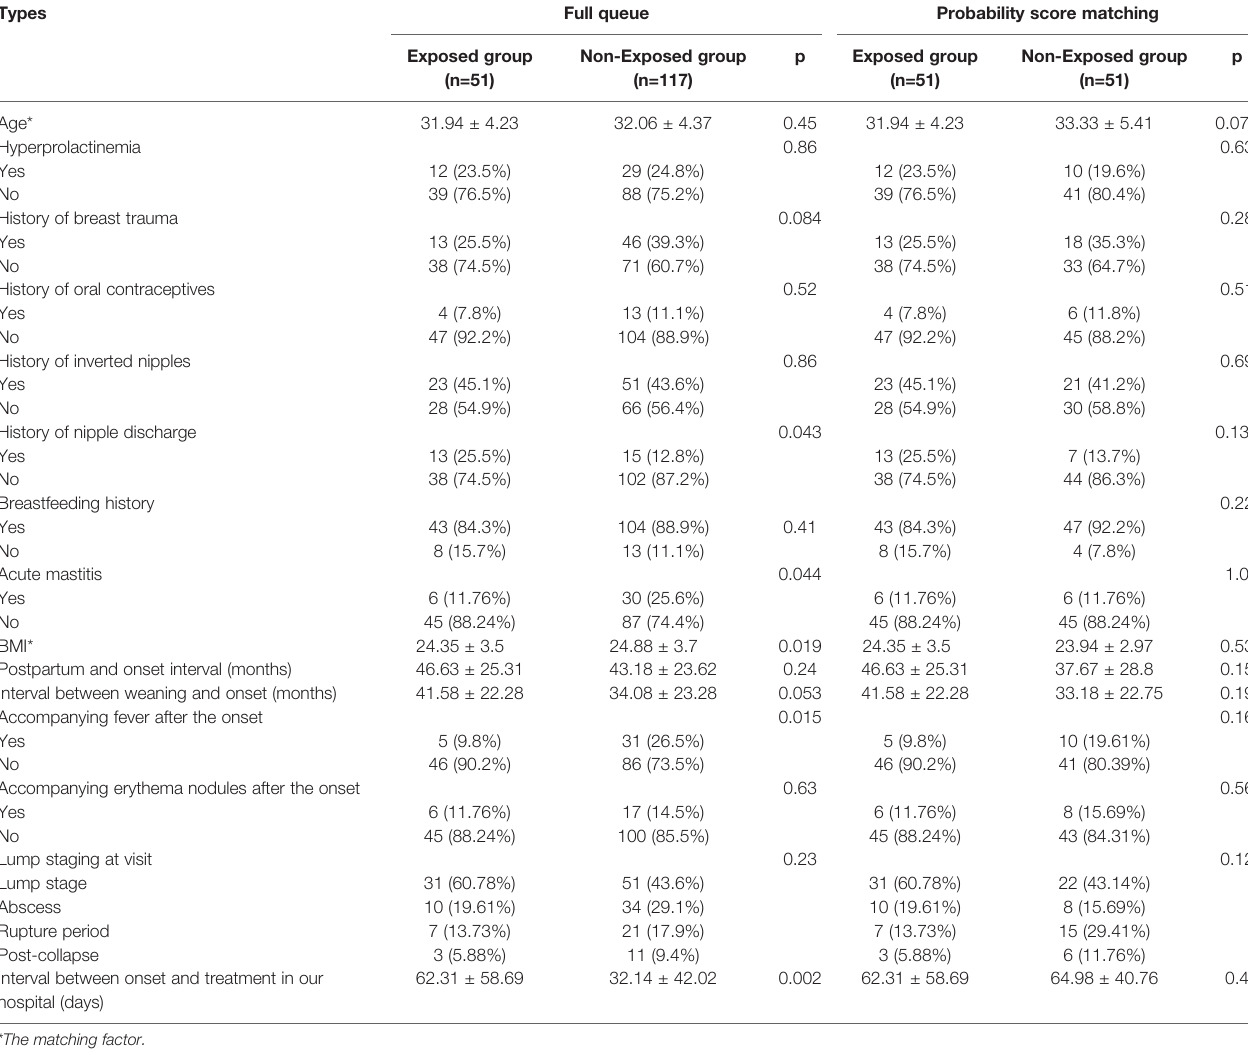
TABLE 1 | Baseline characteristics and propensity score